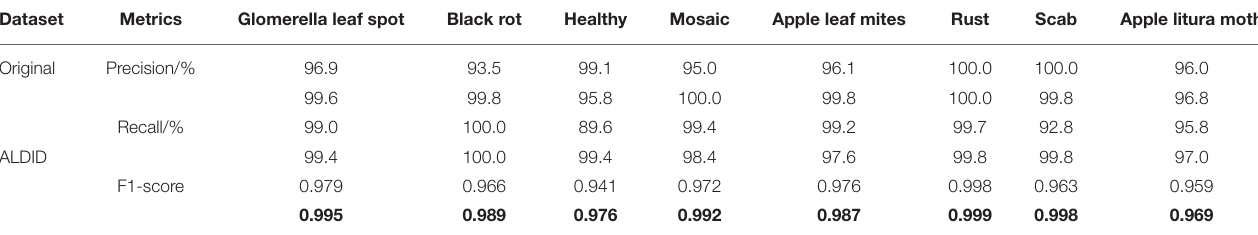
TABLE 4 | Performance of the CA-ENet before and after data augmentation.